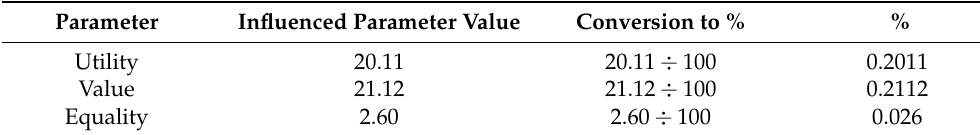
Table 15. Conversion of satisfaction